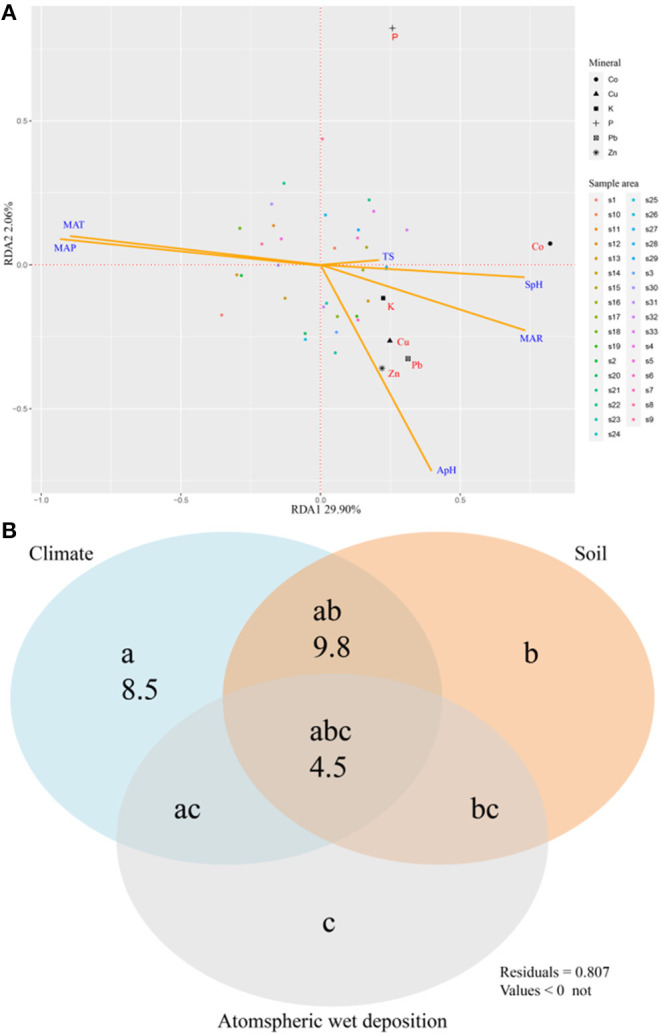
Redundancy analysis showing 6 mineral concentrations of N. commune in relation to environmental factors (A) and variation partitioning (r2) of environmental factors in according for the variation in 6 mineral concentrations (B). The symbols a, b, c represent the independent effects of climate (MAP, MAT, MAR), soil (soil pH, SpH), and atmospheric wet deposition (rainfall pH, ApH; rainfall total salinity, TS), respectively; ab is the interactive effect of climate and soil; ac is the interactive effect of climate and atmospheric wet deposition; bc is the interactive effect of soil and atmospheric wet deposition, and abc is the interactive effect of climate, soil, and atmospheric wet deposition.